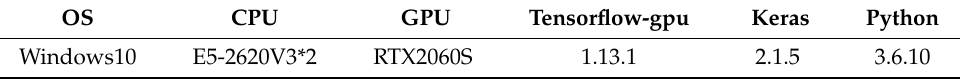
Table 1. Algorithm running